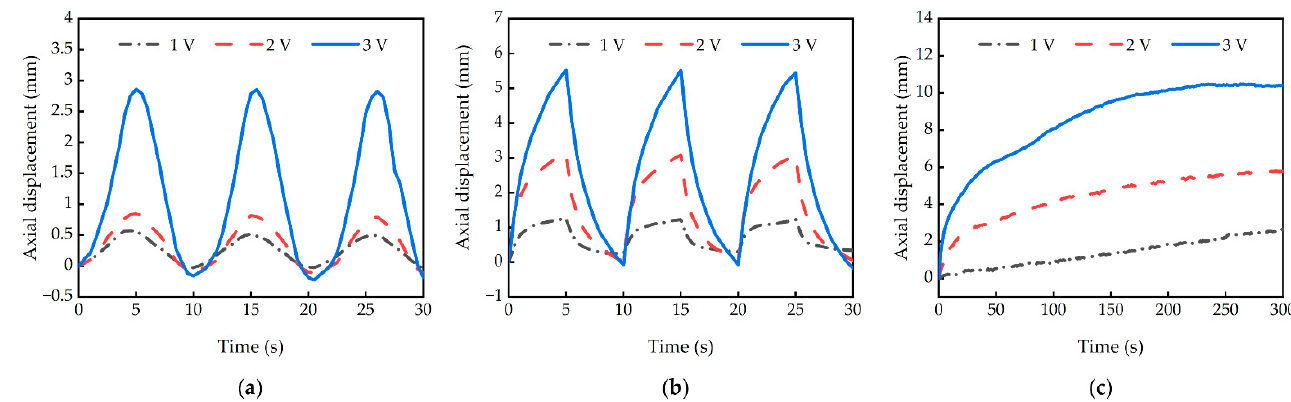
Figure 6. Axial displacements of the helical IPMC actuator under different signals with different amplitudes: ( a ) sinusoidal signal; ( b ) square wave signal; ( c ) DC signal.